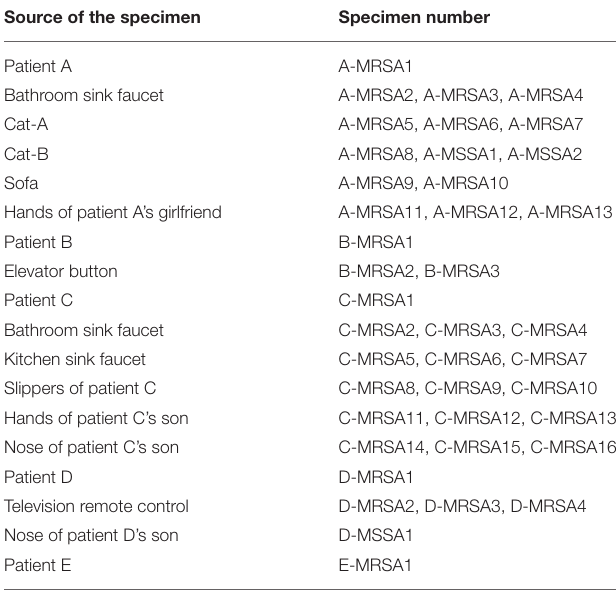
TABLE 3 | Specific sources of specimens in Figure 2 . Source of the specimen Specimen